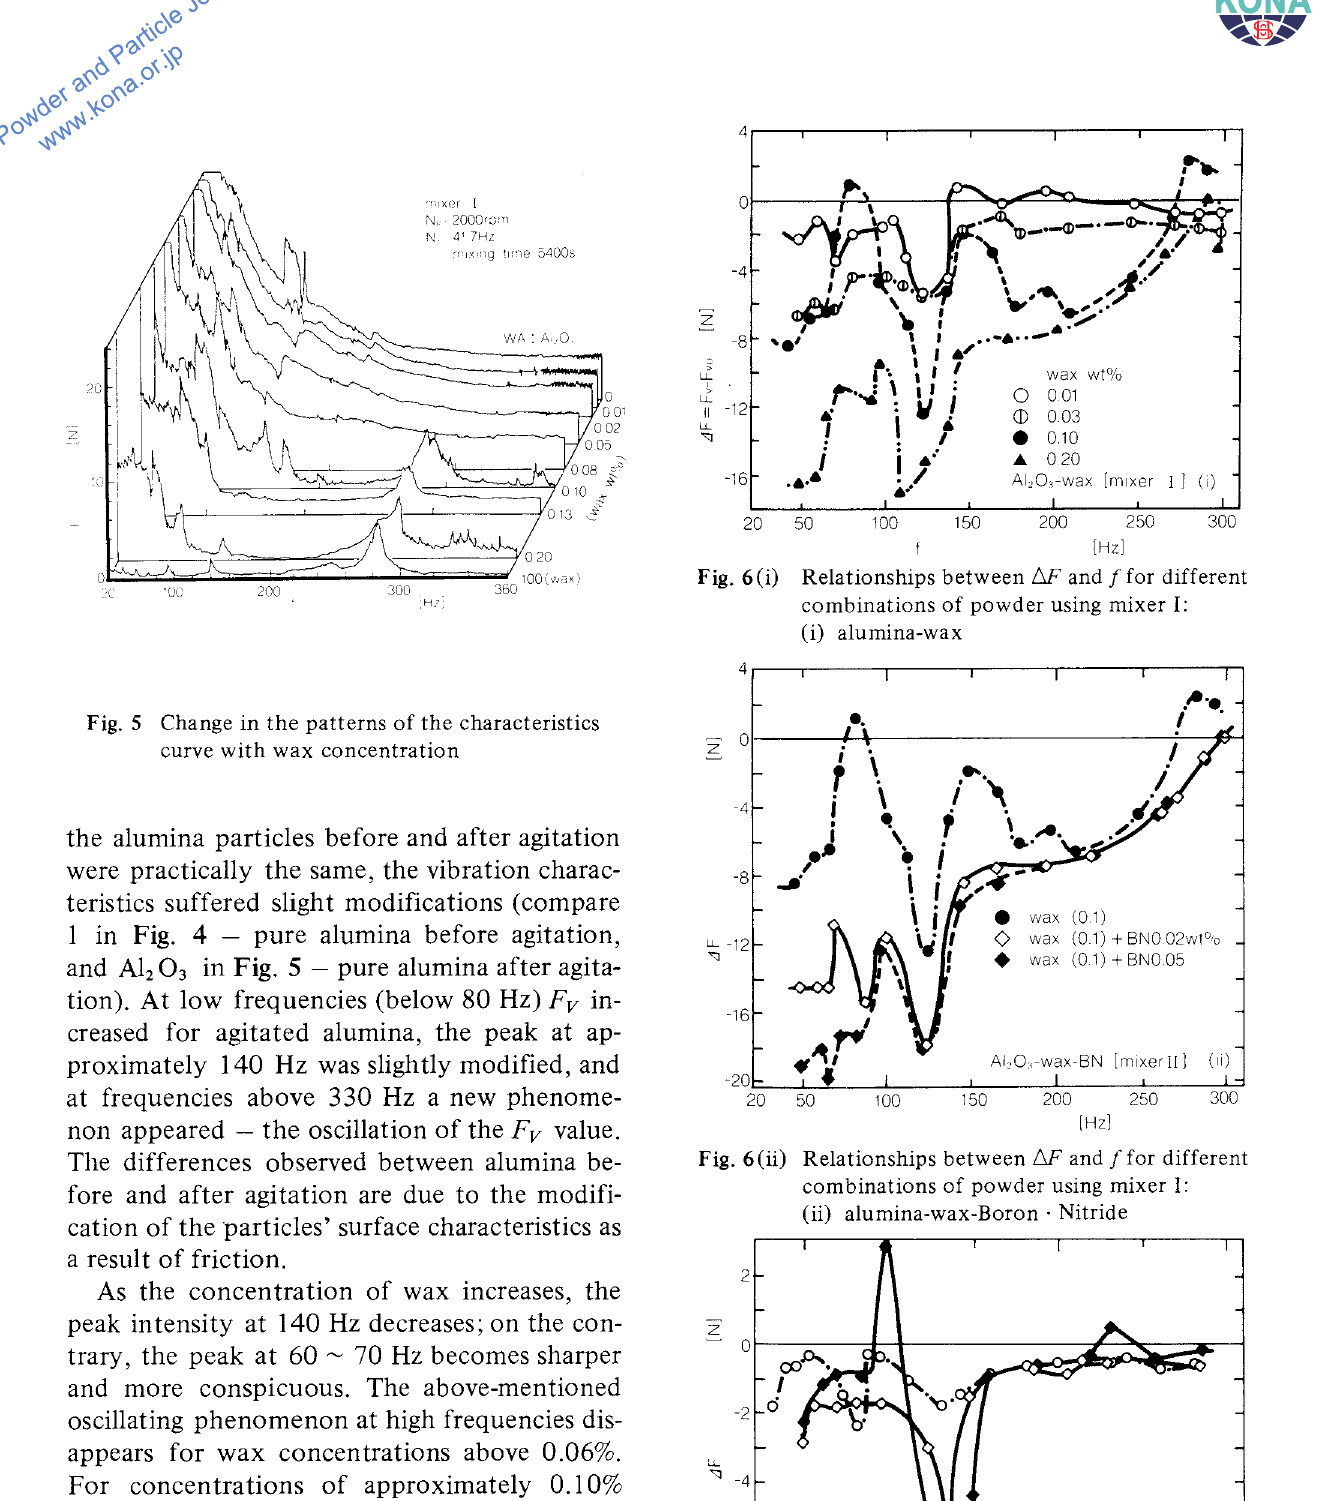
Fig. 6(iii) Relationships between M and /for different combinations of powder using mixer I: (iii) alumina-Boron ·